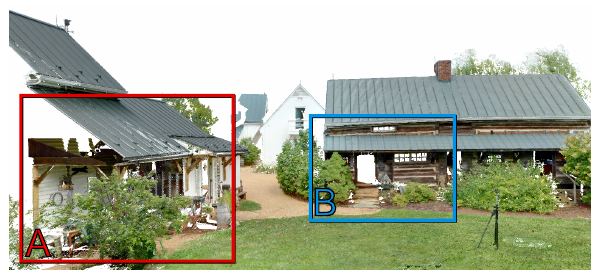
Figure 1. The 106 million point subset of the Pharsalia TLS dataset used for evaluation in this work. Segments Backyard (A) and Stairs (B) are annotated in the